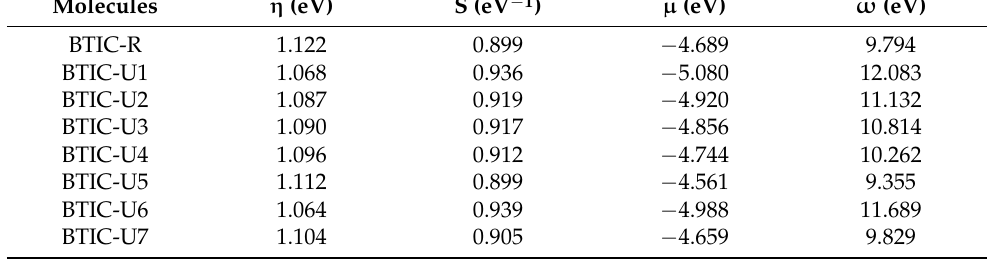
Table 8. Global reactivity parameters of BTIC-R and BTIC-U1 to BTIC-U7. Molecules